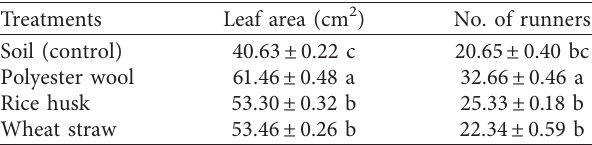
Figure 1: Effect of different growth substrates on survival per- centage (%) of strawberry cv. Chandler. Vertical bars indicate standard error of means ( ± SEM) for three replicates. Table 2: Effect of different growth substrates on vegetative growth of strawberry cv.